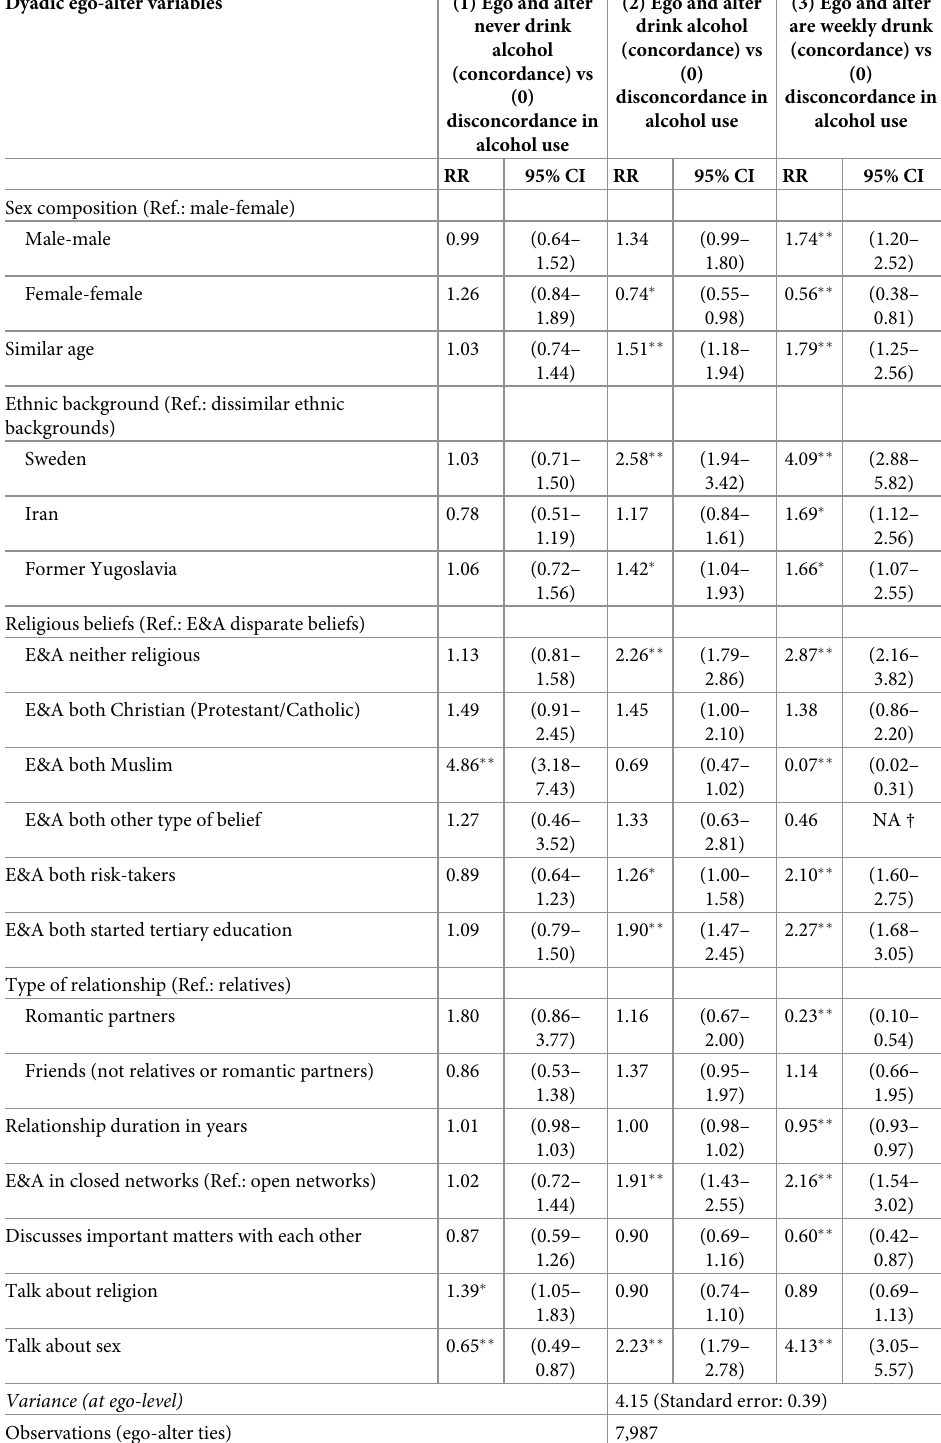
Table 2. Dyadic alcohol habits and social network characteristics: A two-level multinomial logistic regression model with random effects at ego-level (relative risk ratios with 95% confidence